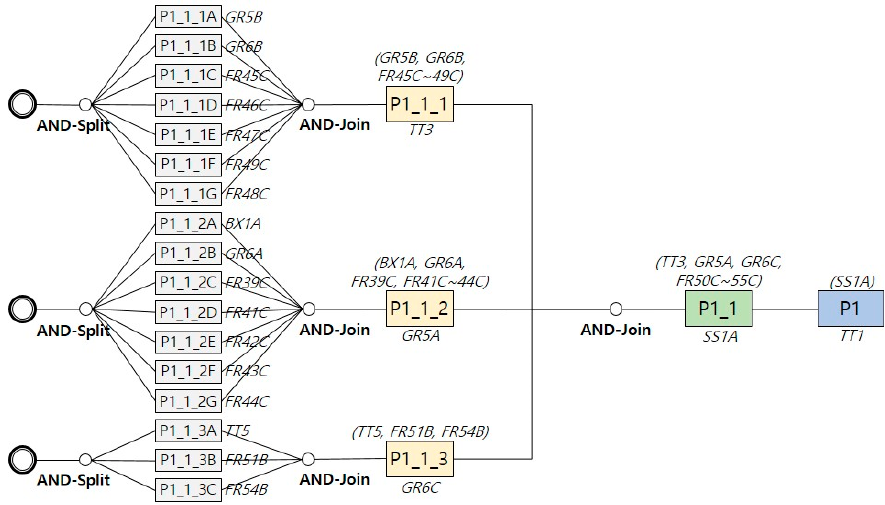
Figure 8. A TT1 block workflow example.